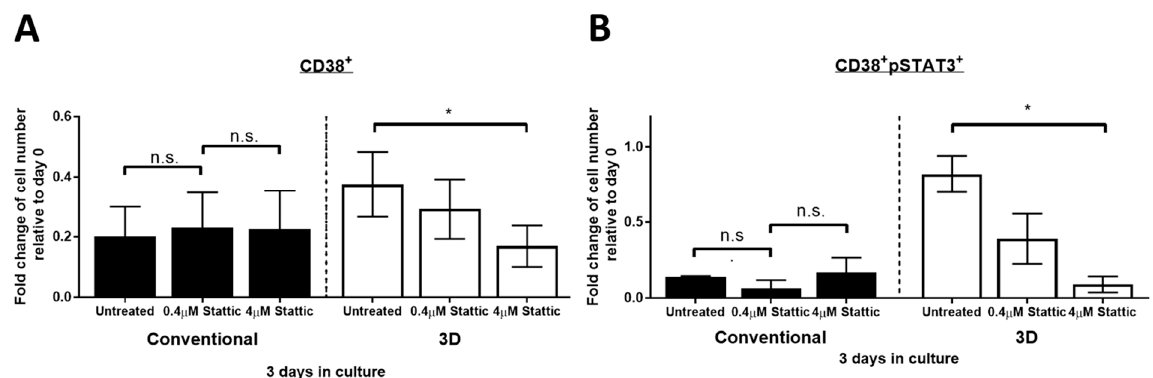
Figure 5. Stattic ablates PM cell viability in 3D culture but not in conventional culture. Fold change of viable ( A ) CD38+ and ( B ) CD38 + pSTAT3+ cell number from 3 MM patients in conventional or 3D culture on day 3 relative to day 0. Doses of 0.4 or 4 µM Stattic were added to cells on day 2 for 24 h. The mean value was indicated with error bars representing standard error. n.s. not significant, * p < 0.05, paired Student’s t -test.